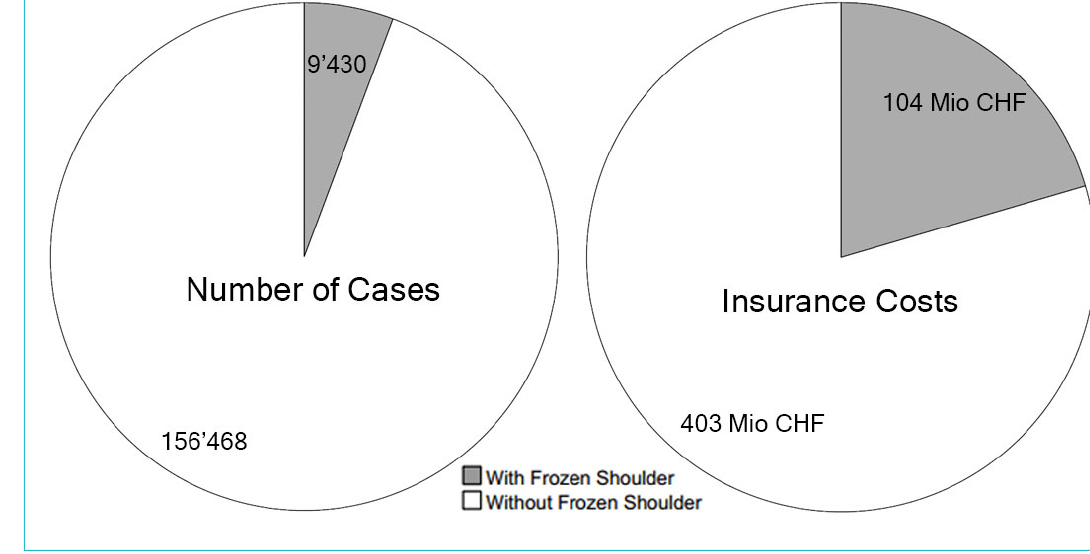
Figure 1: Comparison of the number of shoulder cases (left pie chart) to insurance costs (right pie chart) in the years 2008–2010 (extrapolat- ed) for patients with frozen shoulder (grey piece) and without frozen shoulder (white